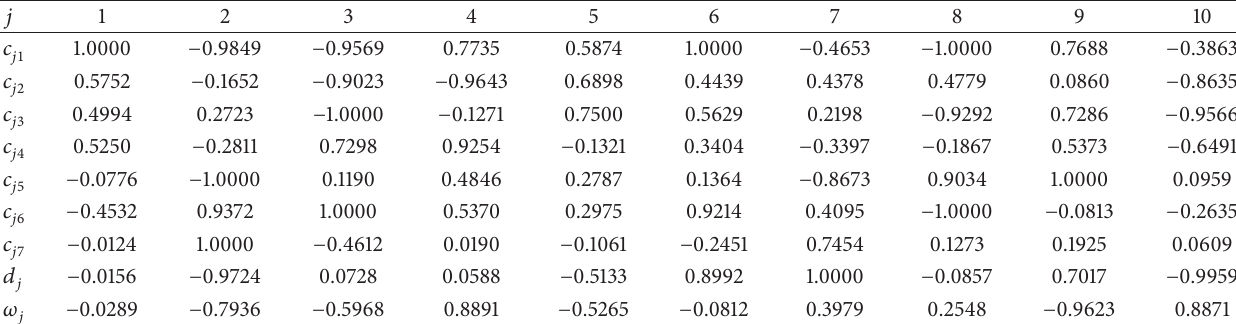
Table 2: The parameters of RBFNN by EDIW-PSO: centers 𝑐 𝑗𝑖 , widths 𝑑 𝑗 , and connection weights 𝜔 𝑗𝑘 .